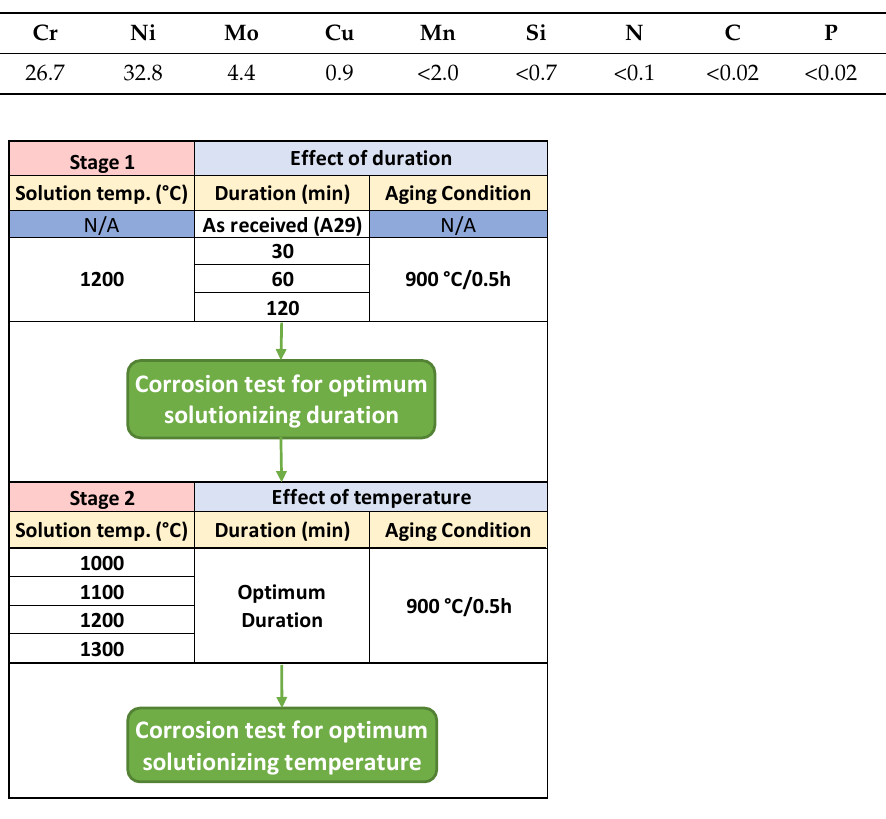
Figure 1. Experimental matrix and flow chart showing the sequence of the heat treatment and corrosion testing.